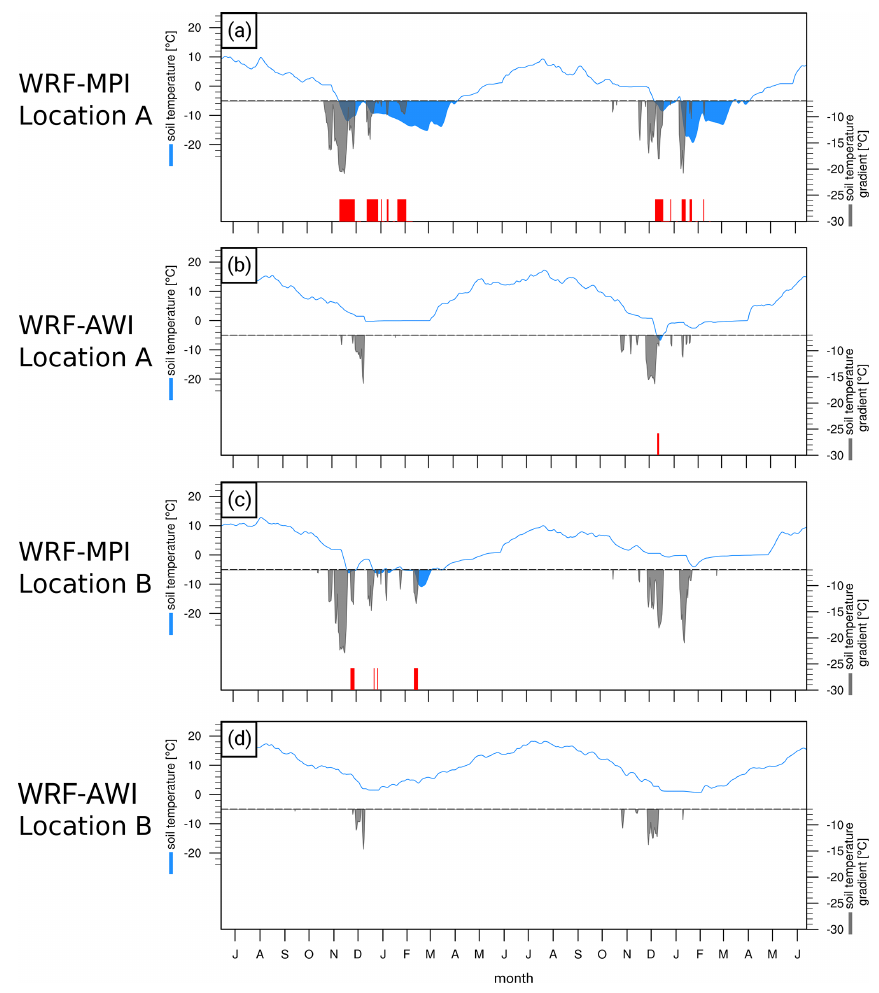
Figure 7. Time series of the daily mean soil temperature and soil temperature gradient at locations A (model grid point 49.8 ◦ N, 2.49 ◦ E) and B (model grid point 46.1 ◦ N, 0.33 ◦ E), as denoted in Fig. 1, simulated in WRF-MPI ( a and c ) and in WRF-AWI ( b and d ) for 2 consecutive years. Blue lines show the development of the soil temperatures in layer 3 (70cm). When the temperatures fall below − 5 ◦ C, the first condition for thermal contraction cracking after Matsuoka et al. (2018) is fulfilled, marked with blue shading and the reference line. The soil temperature gradient between the first layer (5cm depth) and the third layer (grey shading) is only depicted when condition two after Matsuoka et al. (2018) is fulfilled, with a gradient below − 7 ◦ Cm − 1 . Red lines indicate the coincidence of the two